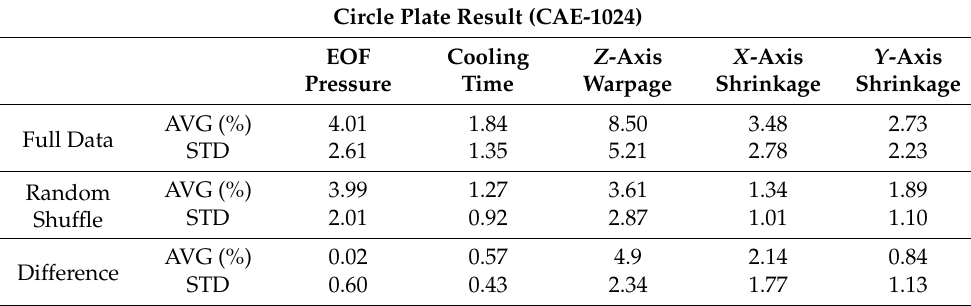
Table 21. Training results for the round flat model (CAE-1024).